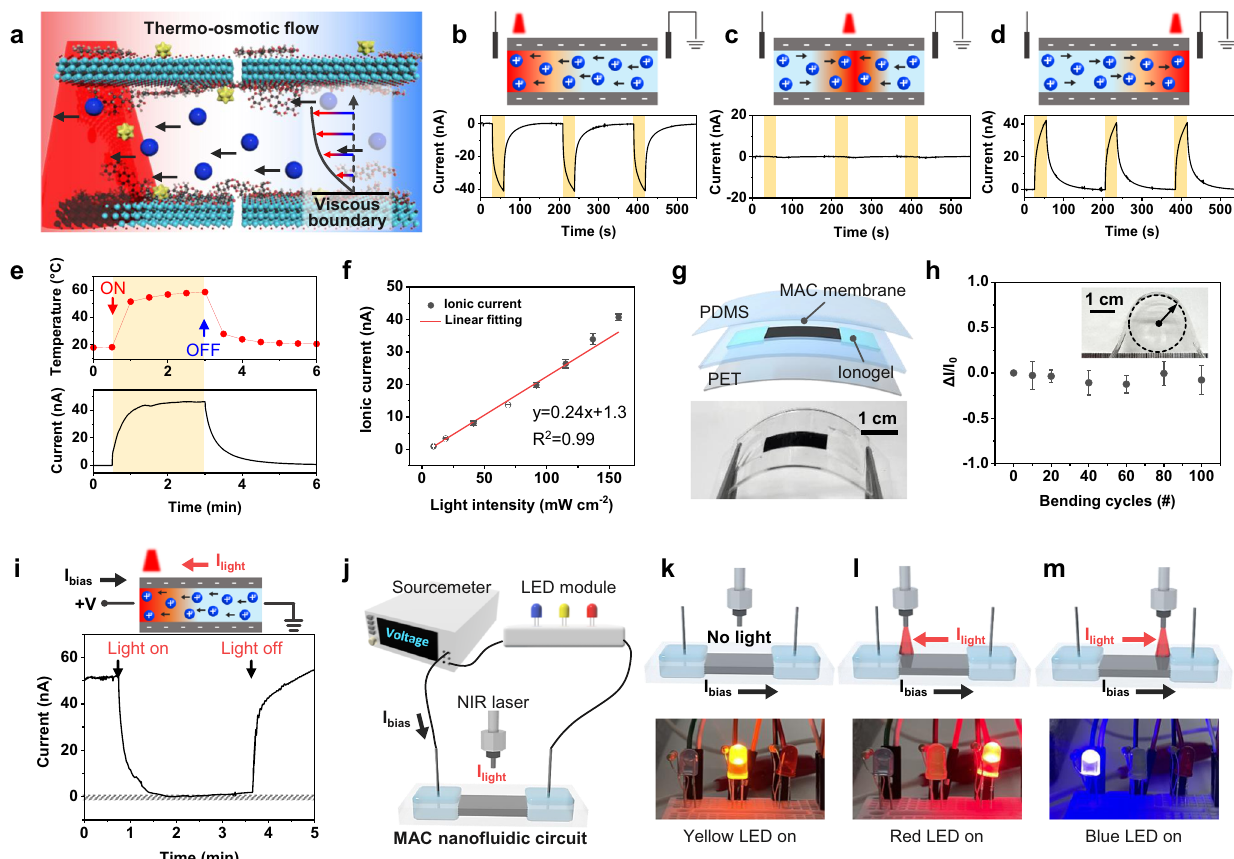
Fig. 5 | Photothermal ionic current of the MAC membrane. a Schematic of thermo-osmotic fl ow in the nonisothermal system. Ionic current of the MAC membrane depending on the location of light irradiation: b left, c center, and d right. e SaturatedioniccurrentundercontinuousNIRirradiation. f Linearly fi tted photothermal current under different light intensities. g Schematic and photo- graph of the fl exible ionogel – MAC fi lm. h Relative current changes ( Δ I/I 0 ) of the ionogel – MAC fi lm under 100 bending cycles. Inset photograph indicates a bent ionogel – MAC sample with a bending radius of 1.2cm. i Photothermally induced ionic switch under a constant voltage bias of 45mV. j